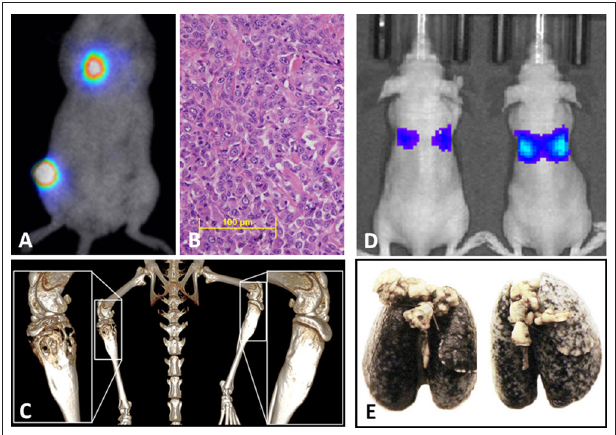
FIGURE 3 | (A) Syngeneic orthotopic mouse model of primary bone OS (K7M3) with concurrent spontaneous pulmonary metastases development visualized by bioluminescent imaging, (B) with corollary histology of established pulmonary metastatic lesions and (C) micro CT images of the OS primary lesion showing profound osteolysis and contralateral unaffected tibia. (D) Bioluminescent imaging of an experimental metastases model in athymic nude mice following tail vein injection with the Abrams (canine OS) luciferase cell line demonstrating correlation between luminescent signal and (E) gross macroscopic tumor